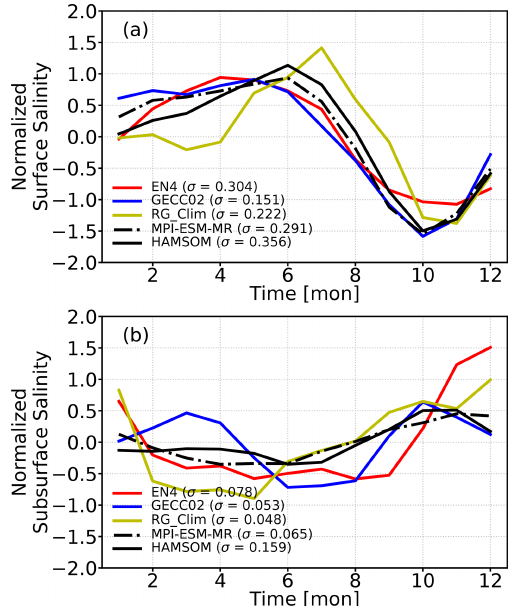
Figure 3. Normalized monthly climatology of surface (a) and sub- surface (b) salinity of the BoB from EN4, GECCO2, RG_Clim, MPI-ESM-MR, and HAMSOM, respectively. The standard devia- tion σ corresponding to each data set is